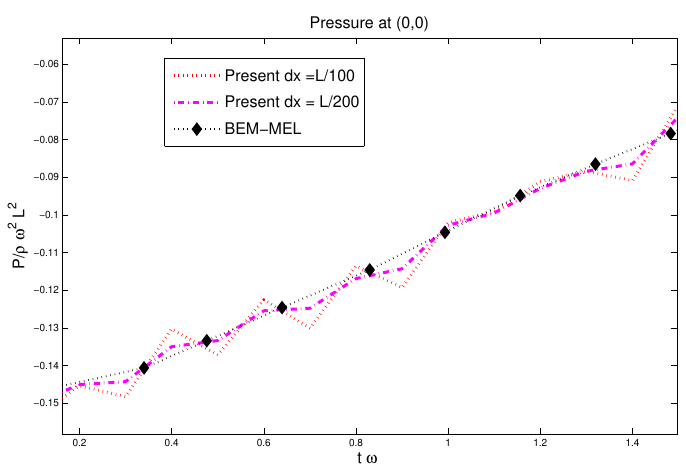
Figure 19. Evolution of an initially-square fluid patch: Time evolution of the pressure at the center of the fluid path. The red dotted line represents the results obtained by the present particle shifting formulation for the particle resolution of dx = L , whereas for the magenta dash-dot line, 100 it corresponds to the particle resolution of dx = L . The black dotted line with diamond marker 200 denotes the pressure results obtained by BEM-MEL solver [61]. The second row of the figure presents a zoom region.